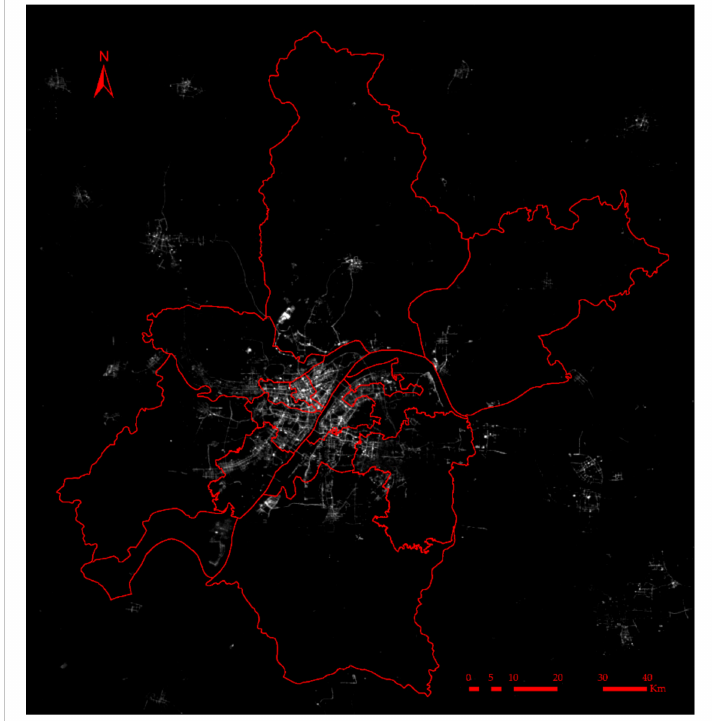
Figure 2. Luojia1-01 night-time light imagery (NTLI) of Wuhan in